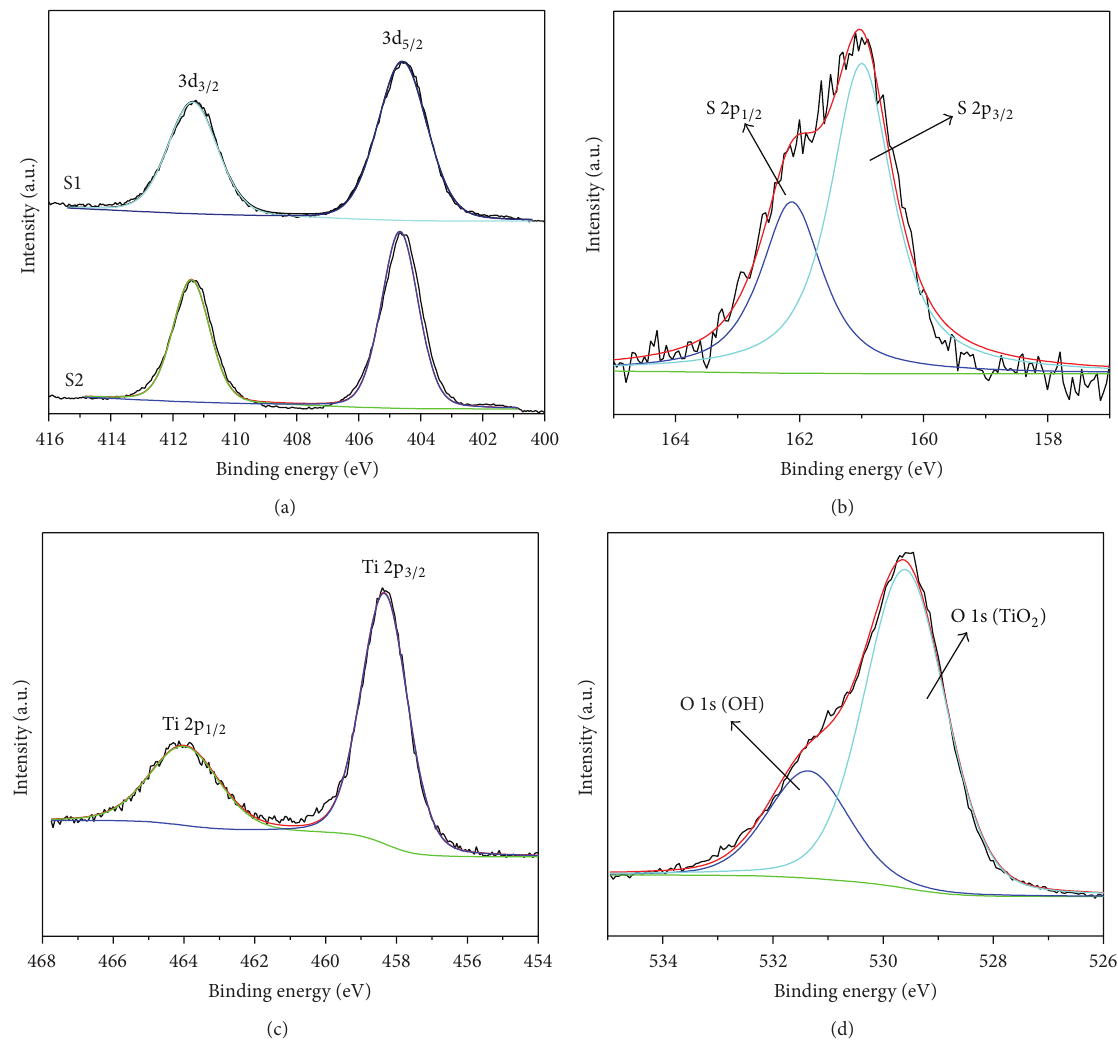
Figure 5: XPS analysis of as-obtained samples (a) Cd 3d of S1-10: 10wt% TiO 2 /CdS (10h) and CdS; (b)S 2p; (c) Ti 2p; (d) O 1s of S1-10: 10 wt% TiO 2 /CdS (10h),